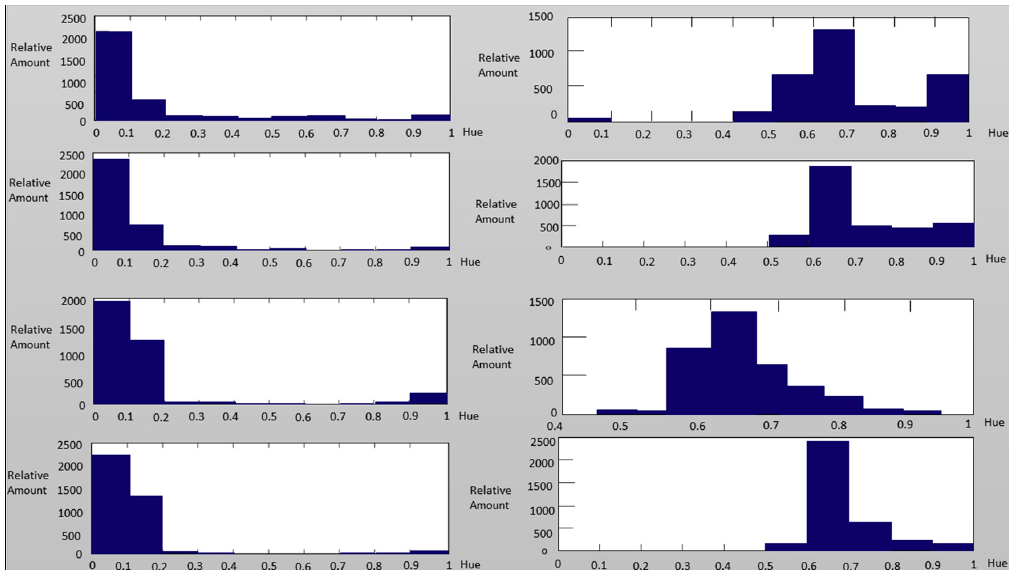
Figure 12. The hue distribution of the authentic image (Left column) and the spoofed image (Right column) using eyes (Upper two rows) and eyebrows (Lower two rows) as examples.